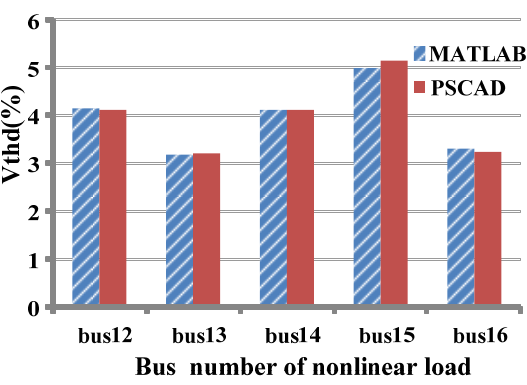
values of five nonlinear loads between harmonic coupled Figure 8. The comparison of V thd admittance matrix model and simulation results.